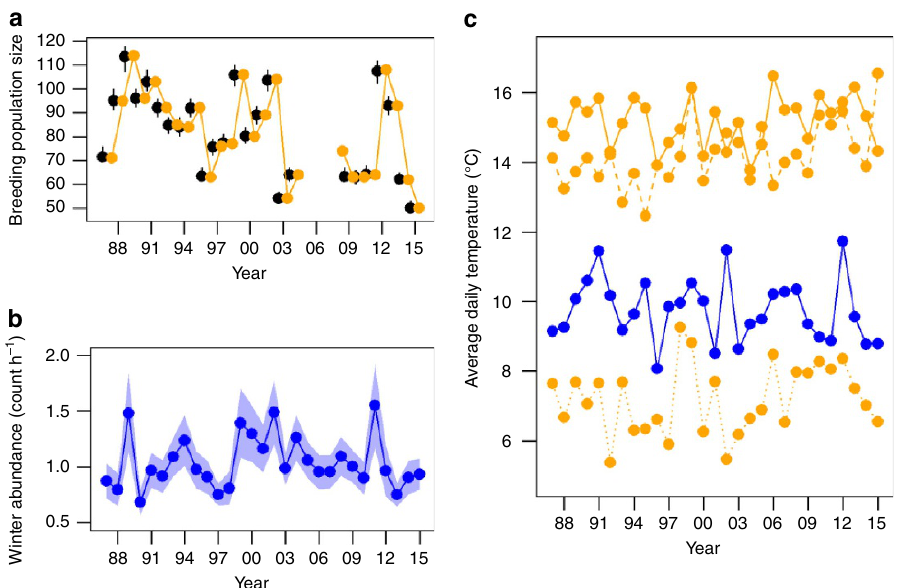
Figure 2 | Average daily temperatures and Savannah sparrow densities at breeding and wintering grounds. ( a ) Mean ( ± 95% credible interval) estimated breeding population size (black points) and population counts (orange) at the breeding grounds. ( b ) Mean ( ± s.e.) number of Savannah sparrows counted per observer hour at Christmas Bird Count survey routes on the wintering grounds. ( c ) Average daily temperatures ( (cid:2) C) at the wintering grounds (blue) and breeding grounds (orange) during the pre-breeding (dotted line), breeding (solid line), and post-breeding (dashed line) seasons.